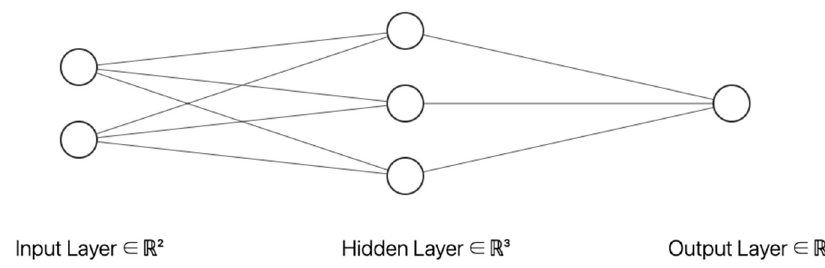
Figure 1. Layer neural